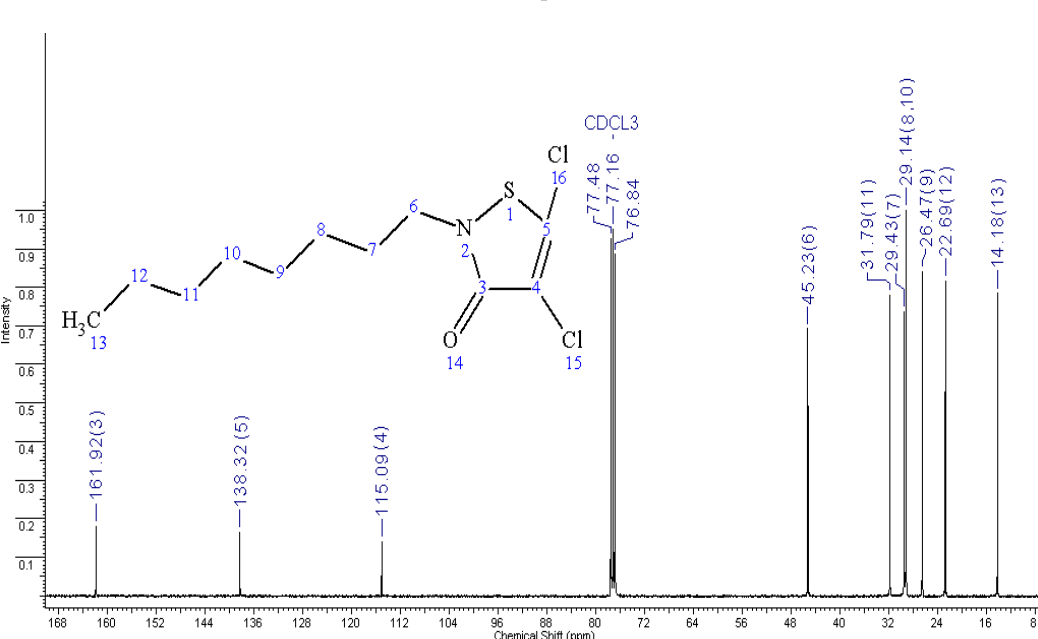
Figure 6. 13 C NMR spectra of DCOIT.